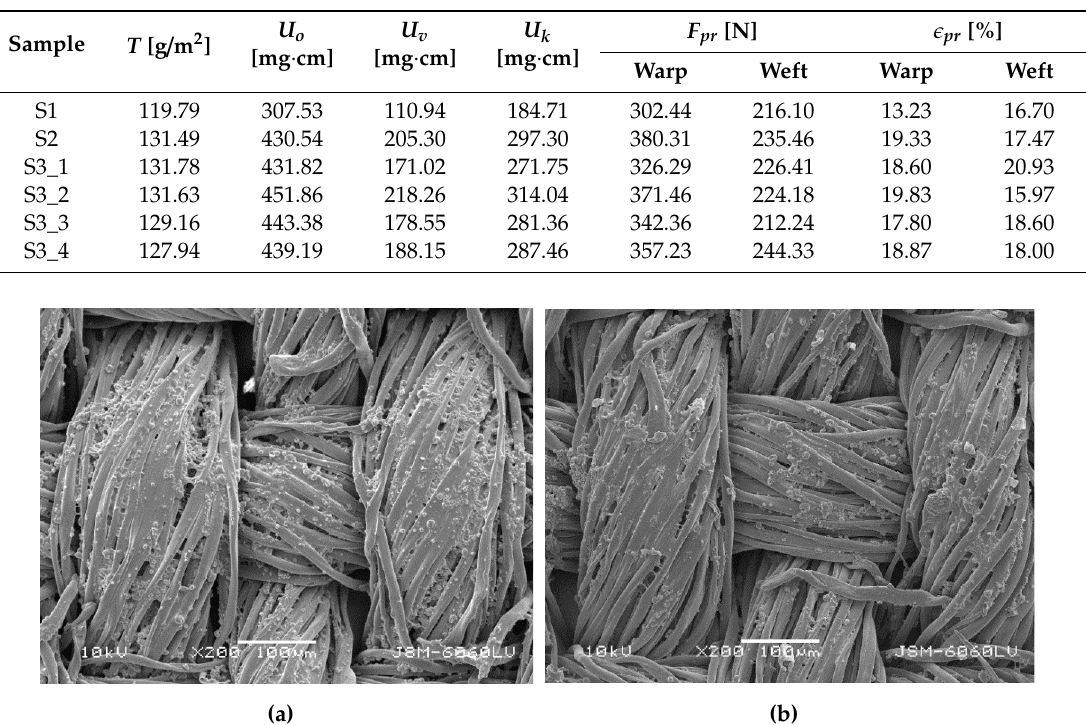
Figure 1. SEM (scanning electron microscope) micrographs of samples S2 ( a ) and S3_4 ( b ) at 200 × magnification.